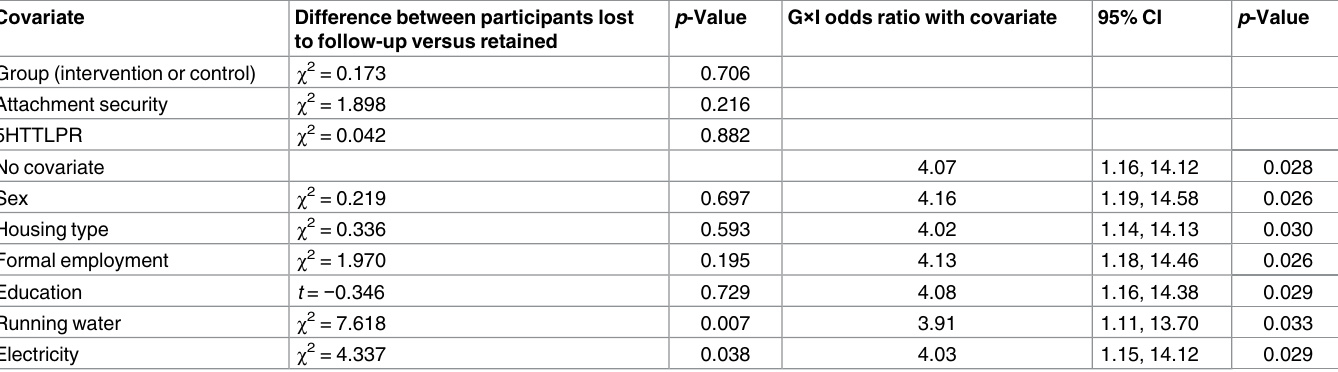
Table 2. Comparison between the sample of 220 adolescents included in the study and the rest of the original sample of 449. Covariate